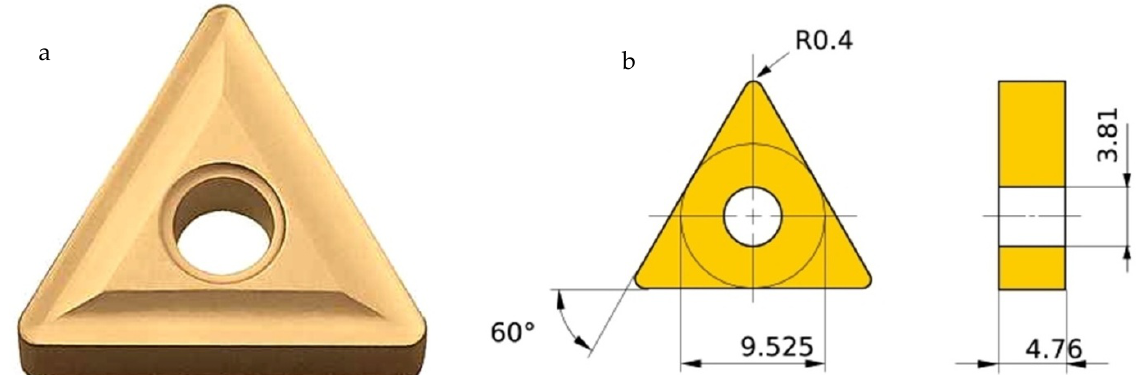
Figure 5. ( a ) Pictorial view; ( b ) dimensions (mm) of the insert (TNMG160404L-ST) used for turning.